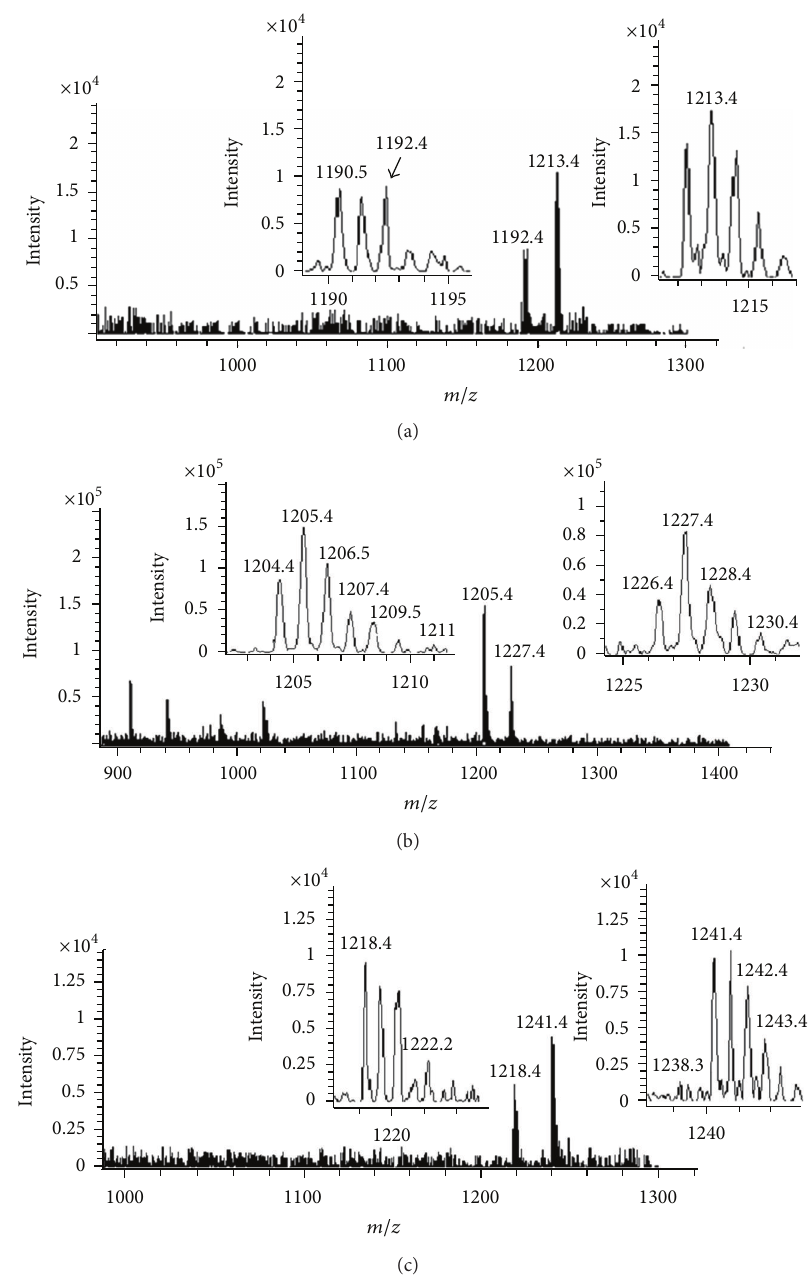
Figure 2: The ESI-MS spectra showing the formation of 5 󸀠 -GMP adducts with complexes PtL b Cl 2 (a), PtL c Cl 2 (b), and PtL d Cl 2 (c).